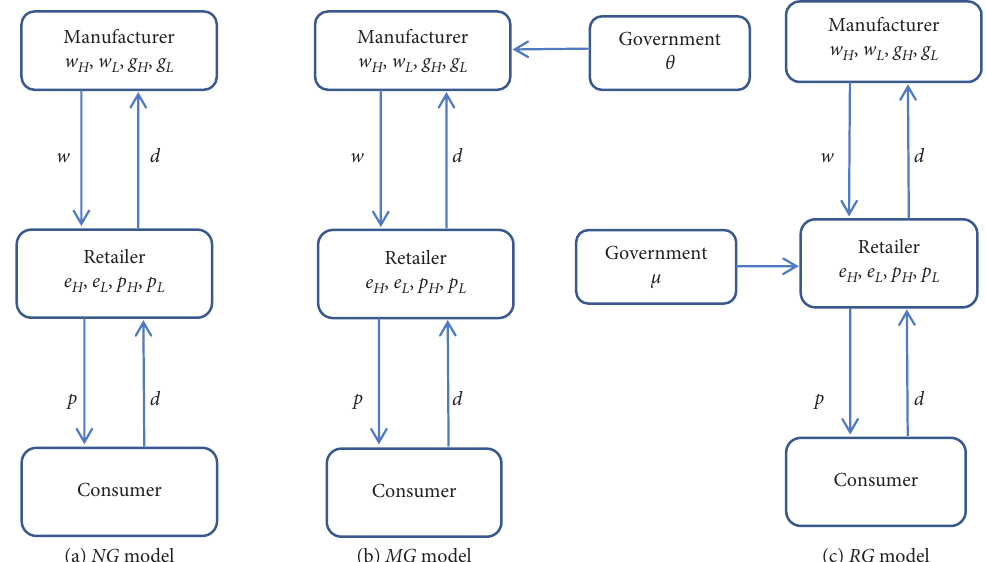
Figure 1: The theoretical model of the green supply chain considering government’s subsidy strategy under asymmetric